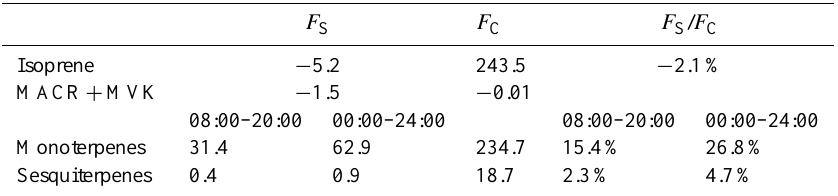
Table 3. The average modelled fluxes (positive upward) from the surface ( F S ) and at the canopy top ( F C ) in units of µgm − 2 h − 1 . A range is given for terpenes with emissions from 08:00–20:00EDT only (no nighttime emissions) and emissions from 00:00–24:00EDT (full day). F S F C